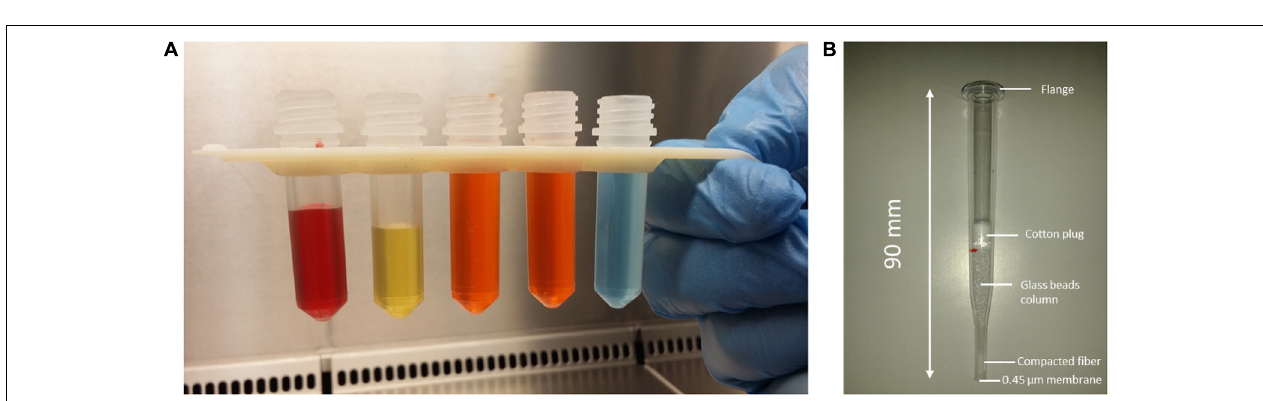
FIGURE 3 | Overview of the preparation of mobile rack with pre-filled extraction strips, 1 mL pipette tips, and assembled filter wands. Only 2–5 min is needed to prepare a run by filling under the class II safety hood 1 mL of positive blood culture in well 1 of each extraction strip.